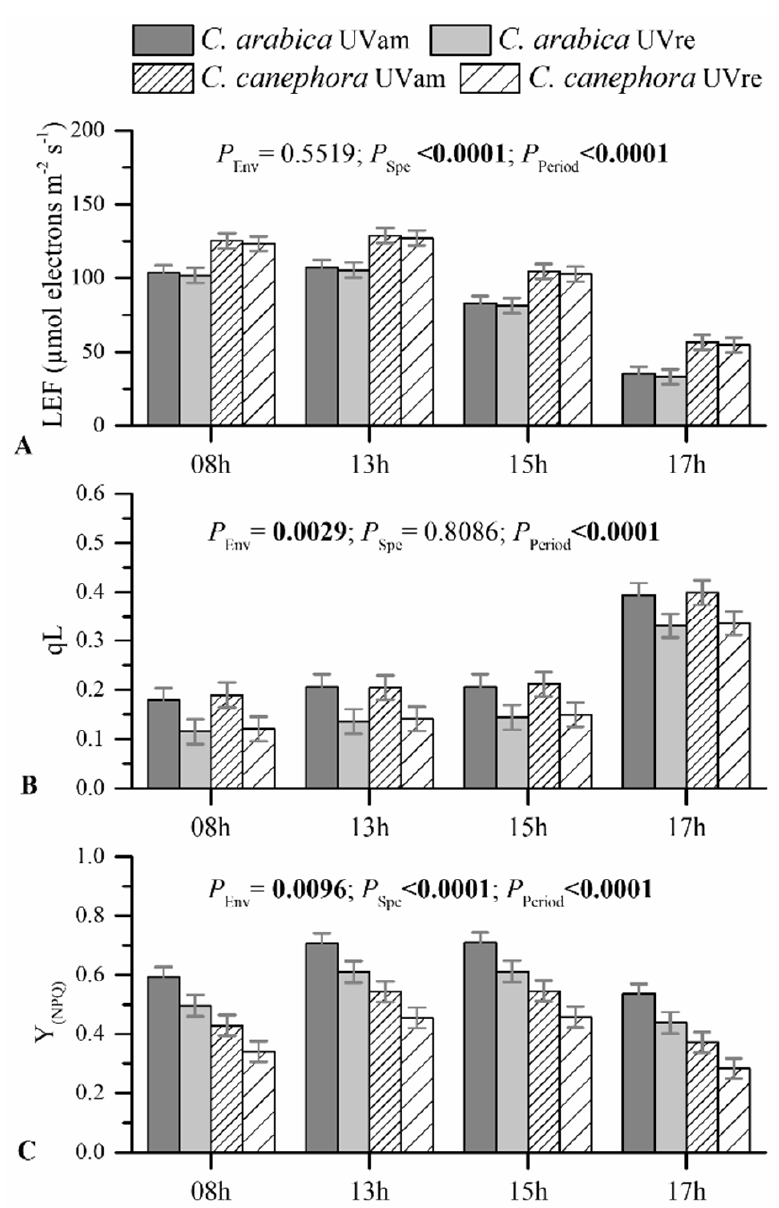
Figure 6. Linear electron transport (LEF) ( A ), the fraction of “open” PSII centers—q L ( B ), and the yield for dissipation by downregulation—Y (NPQ) ( C ), measured in light-adapted leaves during four diurnal periods (8.00 a.m., 1.00, 3.00, and 5.00 p.m.) for Coffea arabica and C. canephora grown under near ambient (UVam) and reduced (UVre) UV levels (Env). Estimated mean values ± S.E. (n = 8) and ANOVA p -Values are shown. ANOVA p -Values < 0.05 are marked in bold. The ratio of energy dissipated through non-photochemical processes (Y (NPQ) ) also decreased under UVre in both species, as compared to their respective UVam values, in all evaluated periods (Figure 6C). Notably, C. arabica maintained greater Y (NPQ) values com- pared to C. canephora in both UV conditions and throughout the diurnal period, reflecting a higher energy dissipation through non-photochemical processes. Regarding the evaluation of the diurnal period, higher Y (NPQ) values were observed in the period of 1.00 to 3.00 p.m. than at 8.00 a.m. and 5.00